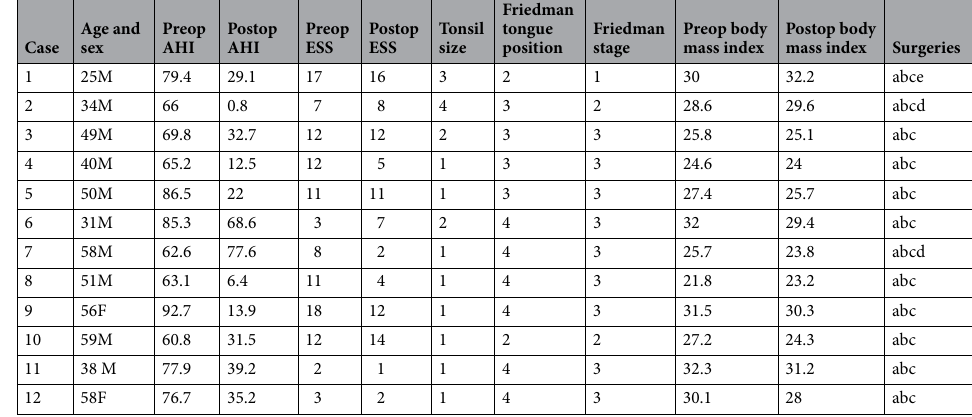
Table 1. Enrolled subjects ordered by their visit times. Preop: preoperative. Postop: postoperative. Surgeries: surgical procedures in the multilevel surgery. a: modified ZPP with one-layer closure, b: open CO2-laser tongue-base resection, c: bilateral septomeatoplasty, d: endoscopic sinosurgery, e: adenoidectomy.